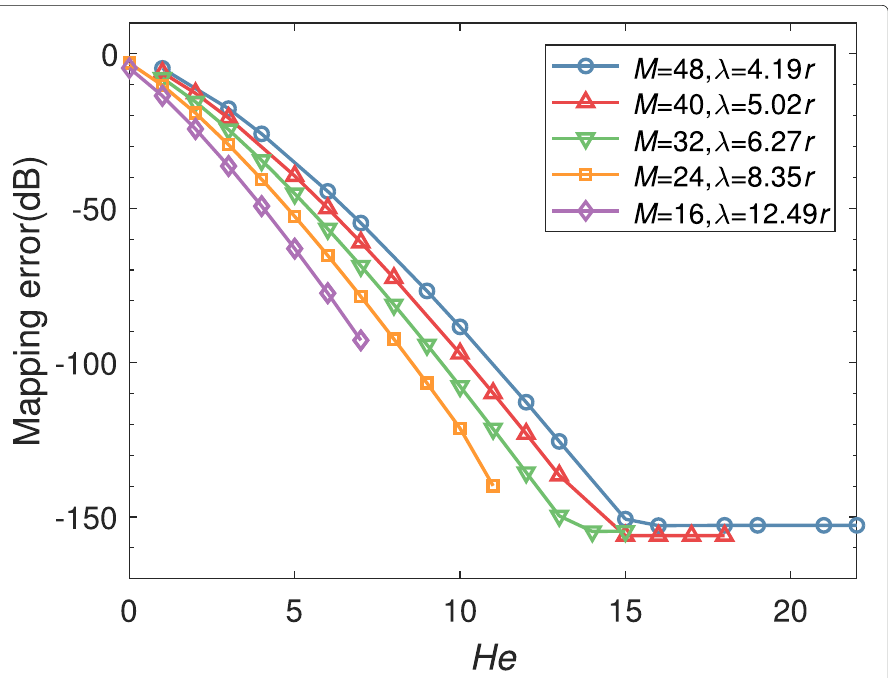
Fig. 2 Mapping error as a function of phase mode H e for UCA with r /λ , in which the circumferential spacing between adjacent sensors is 0.0313 r . The maximum of phase mode is respectively 7, 11, 15, 18, and 22, correspondingly M =16, 24, 32, 40,